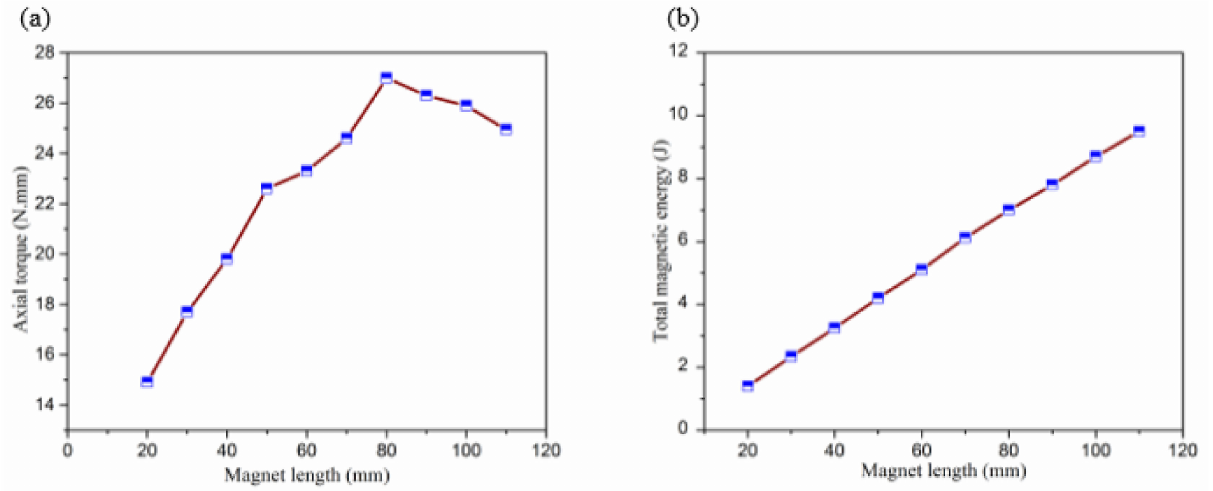
Figure 10. ( a ) Magnetic length vs. axial torque generation, and ( b ) magnetic length vs. total magnetic